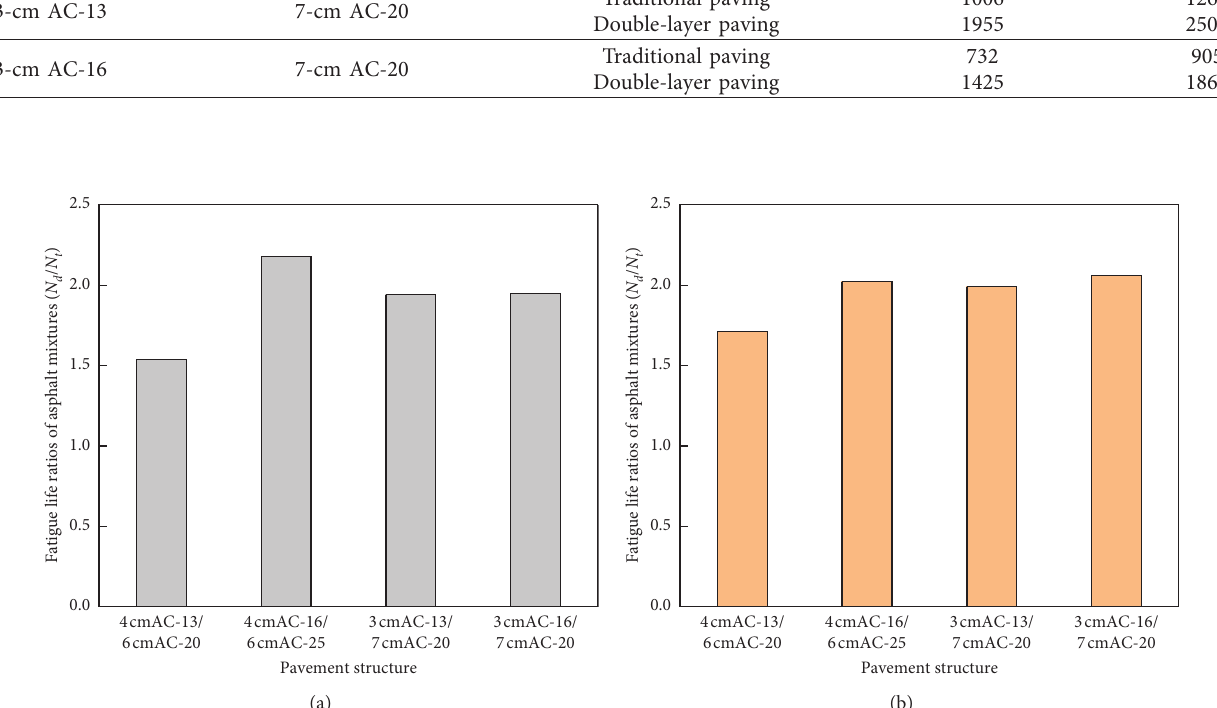
Figure 6: Fatigue life ratios of the asphalt mixtures with different paving technologies. (a) Failure probability � 5%. (b) Failure probability �